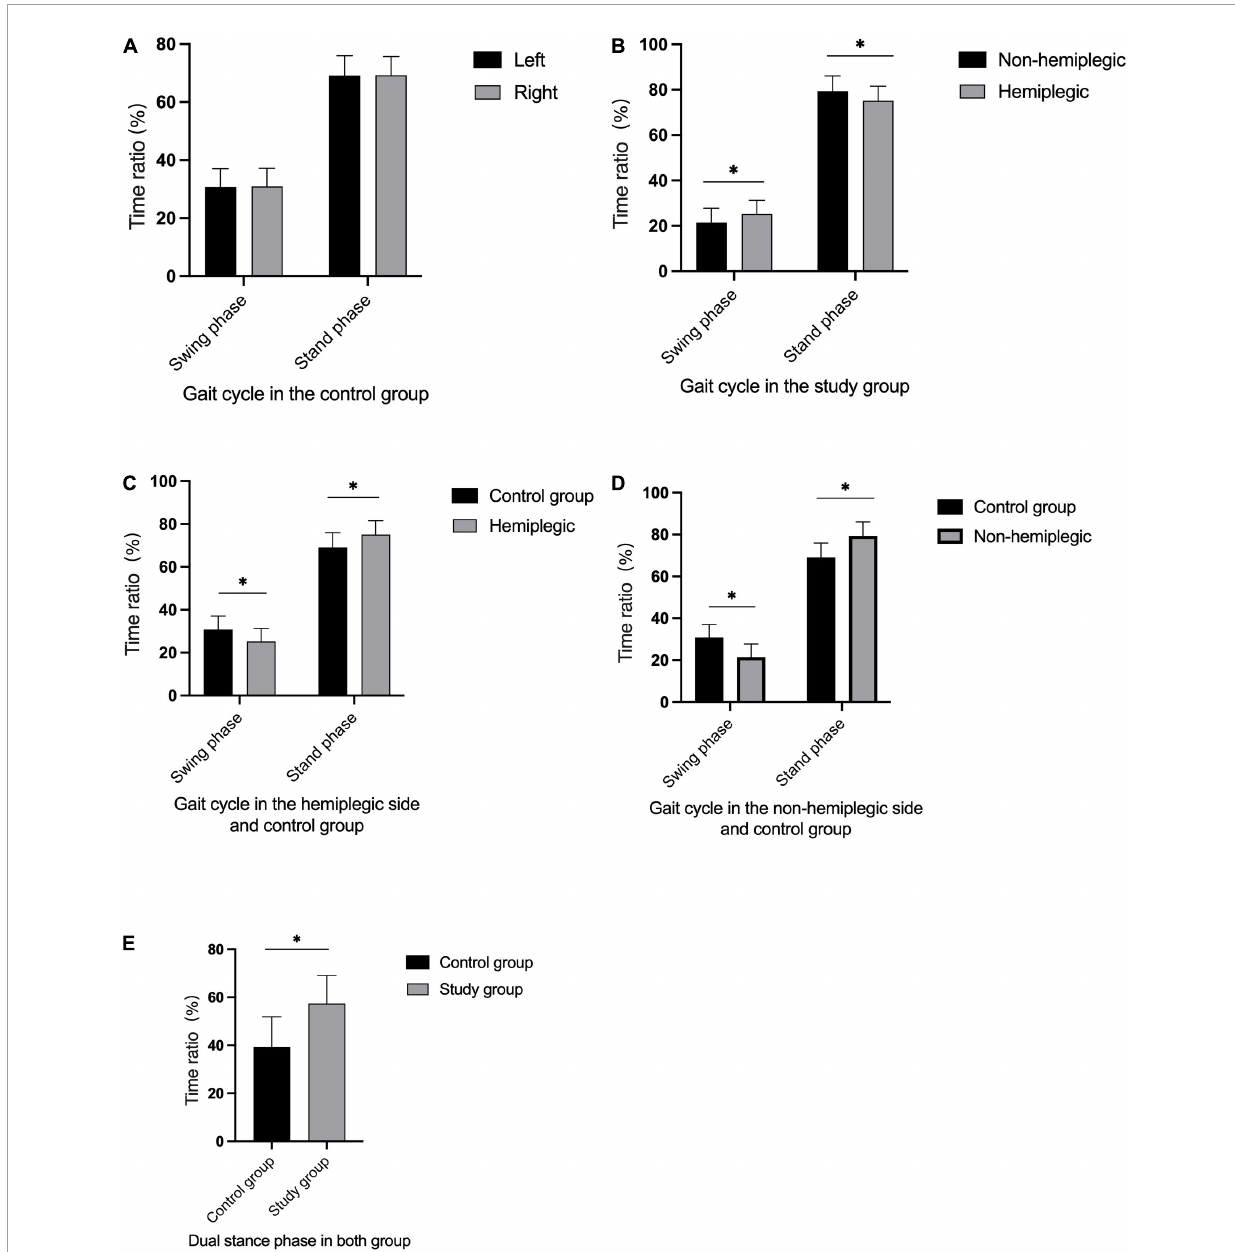
FIGURE2 Gait cycle in both group. There was no significant difference in bilateral gait cycle in the control group (A) ( P > 0.05). The non-hemiplegic swing and stand phase were significantly higher than in the hemiplegic side in the study group (B) ( P < 0.001). The swing phase in the hemiplegic side in the study group was significantly lower than in the control group, while the stand phase in the hemiplegic side was higher than in the control group (C) ( P < 0.05). The swing phase in the non-hemiplegic side in the study group was significantly lower than in the control group, while the stand phase in the non-hemiplegic side was higher than in the control group (D) ( P < 0.05). The dual stand phase in the study group was higher than in the control group (E) ( P < 0.001). ∗ Indicates significantly different.